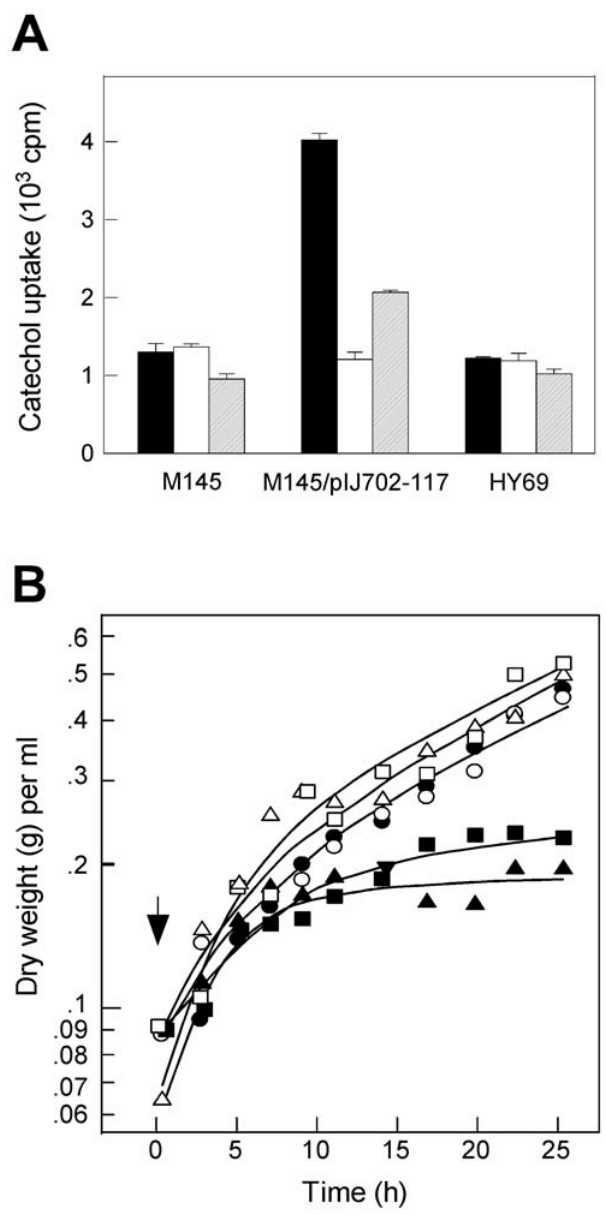
Figure 7. Effect of melC and melD on catechol uptake by Streptomyces . A. Catechol uptake. [ 14 C]-catechol was added to a final concentration of 62.5 m M (1.78 6 10 6 dpm/ m mole) to cultures growing in different liquid media at OD 600 of 0.4. After 15 min, 20 ml of the cultures was removed and harvested on a filter and radioactivity determined. Media: solid bars, R5; open bars, MM; hatched bars, MMT. The horizontal bars represent the standard deviations. B. Sensitivity of liquid cultures. Catechol was added to a final concentration of 1 mg/ml to the cultures growing in R5 at the time indicated (arrow). At various later times, 3 ml of each culture was removed, and the dry weight was determined by filtration and drying at 60 u for 1.5 h. Filled symbols, catechol added; open symbols, no catechol added. Circles, M145; triangles, M145/pIJ702-117; squares, HY69. doi:10.1371/journal.pone.0007462.g007 Why is MelC2 secreted and MelD2 is not? All MelC2 sequences lack a signal peptide. MelC2 of S. antibioticus was shown to be secreted via the Tat pathway by complexing with MelC1 [6], which contained a signal peptide and a Tat motif [25]. Proteins